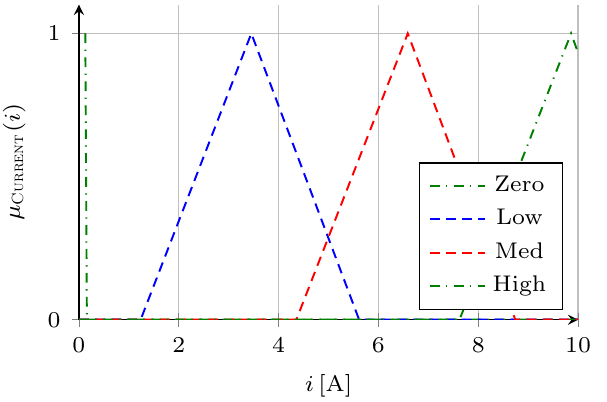
Figure 3. Membership functions for the input fuzzy sets corresponding to the linguistic variable C URRENT .